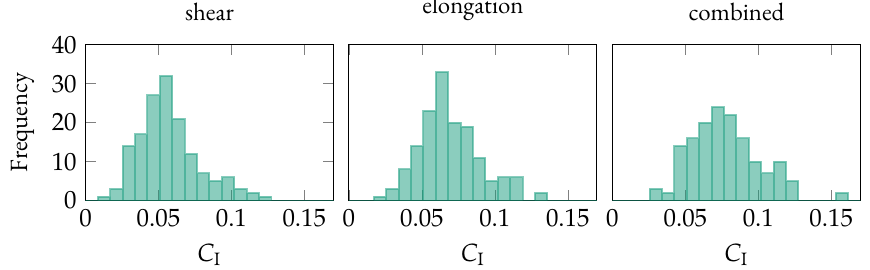
Figure 8. Histogram of FT parameters under consideration of the governing flow type.